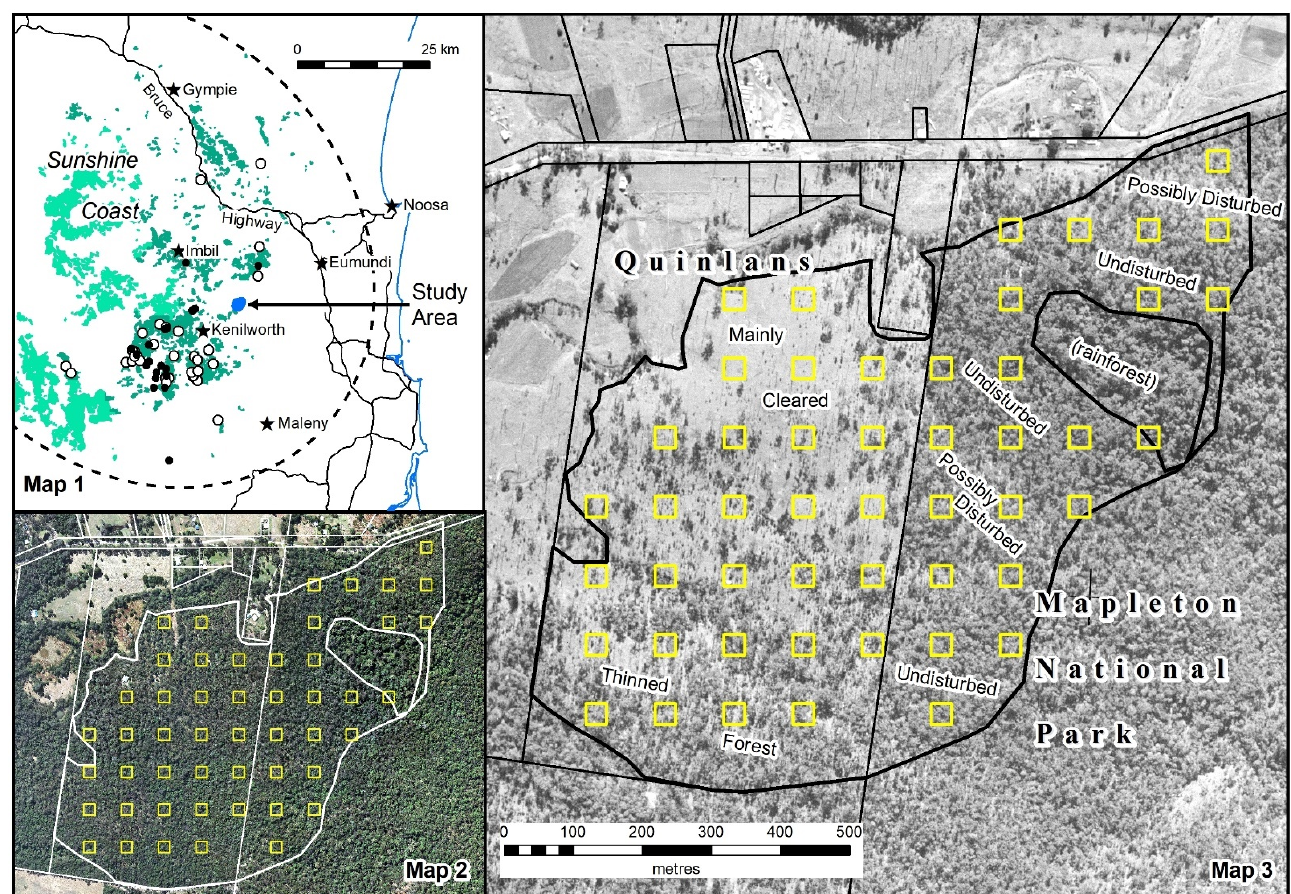
Figure 4. Map 1 : Location of the study site in the Sunshine Coast subregion (see, also, Figure 1). Map 2 : 2006 aerial photo (Photo: QAP6183058.jpg, Source: https://qimagery.information.qld.gov.au/, accessed on 27 June 2018) showing the forest cover as near ‐ contemporaneous with the ALS acquisition in 2009. Map 3 : Focus study area (thick black outline, rainforest excluded from study) in a 1940 aerial photo (Photo: 1940jul08_MAP648_76044_2011.tif, Source: https://qimagery.information.qld.gov.au/, accessed on 19 August 2018). Thinner black lines outline the tenure boundaries. Labels show disturbance types from the interpretations of the 1940 photo. Areas in Mapleton National Park marked “Possibly Disturbed Forest” might reflect the topographic position (dryer northerly aspect) and not disturbance per se. Yellow squares in Maps 2 and 3 show locations of 50 ALS virtual